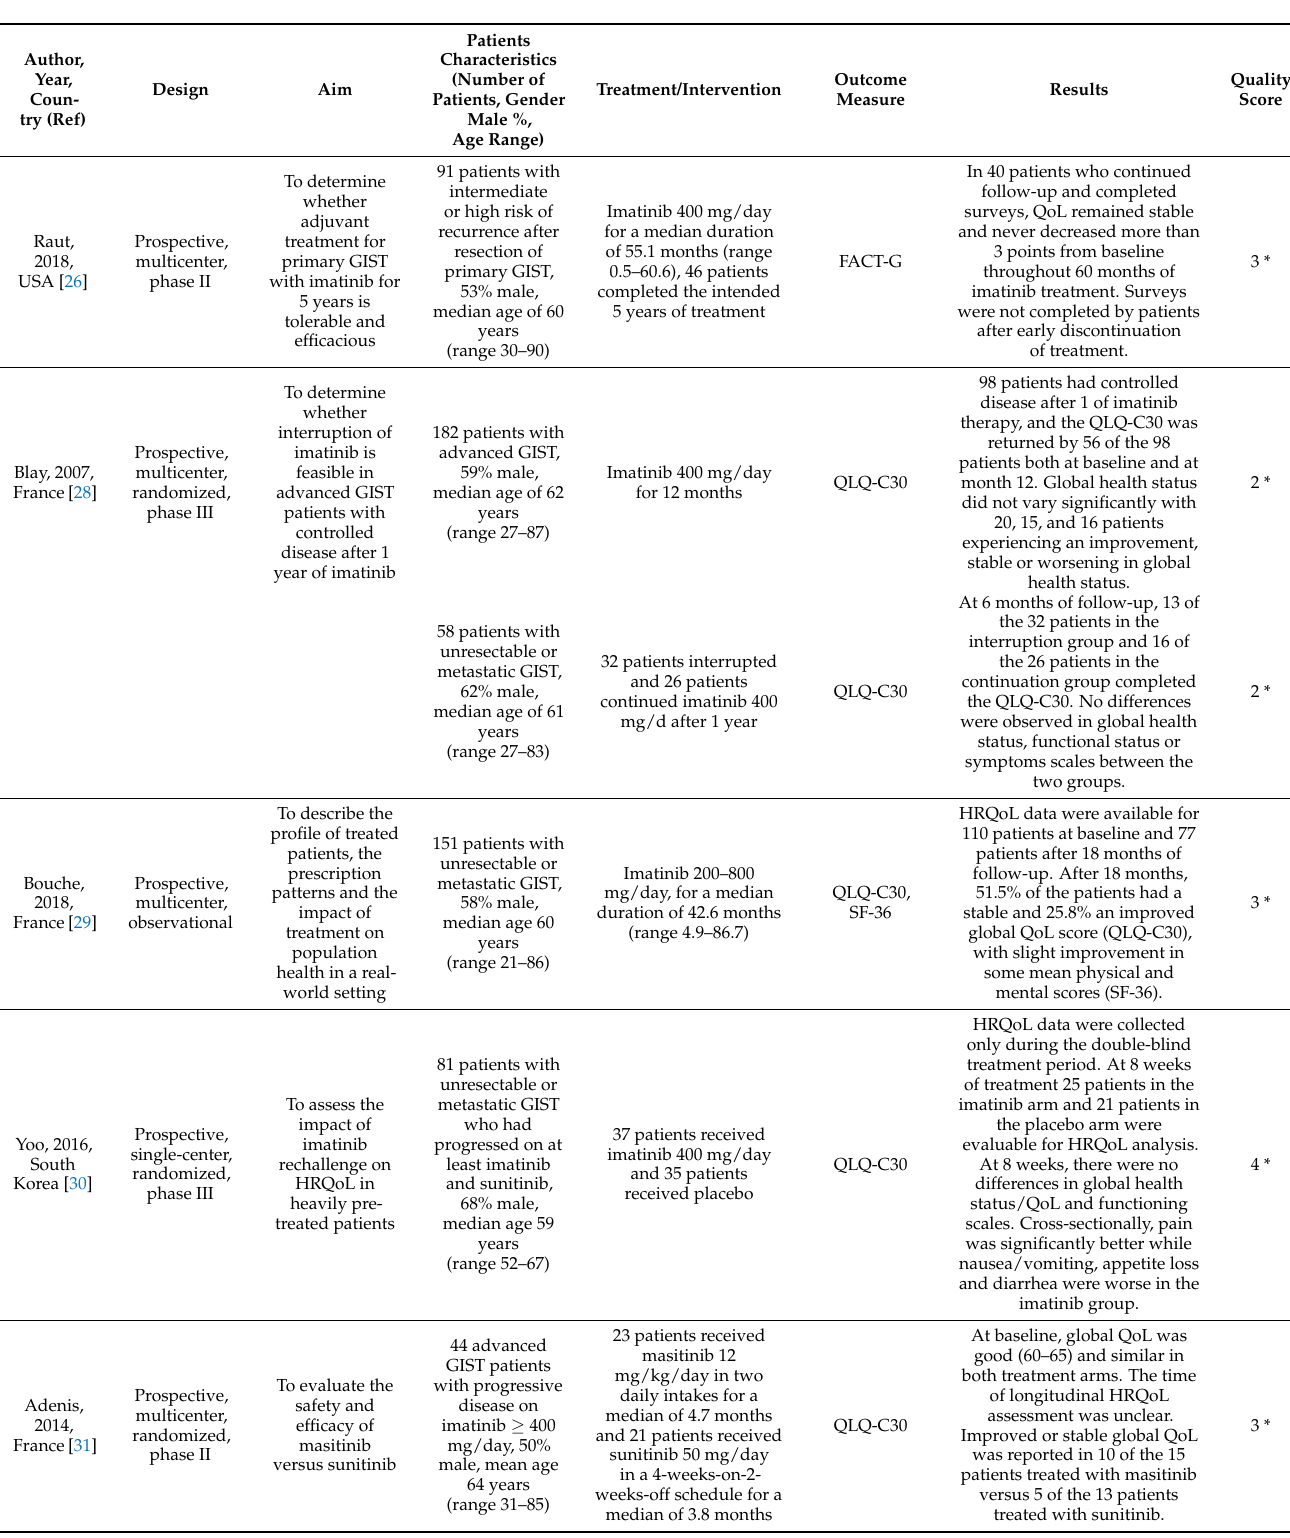
Table 1. Studies reporting on